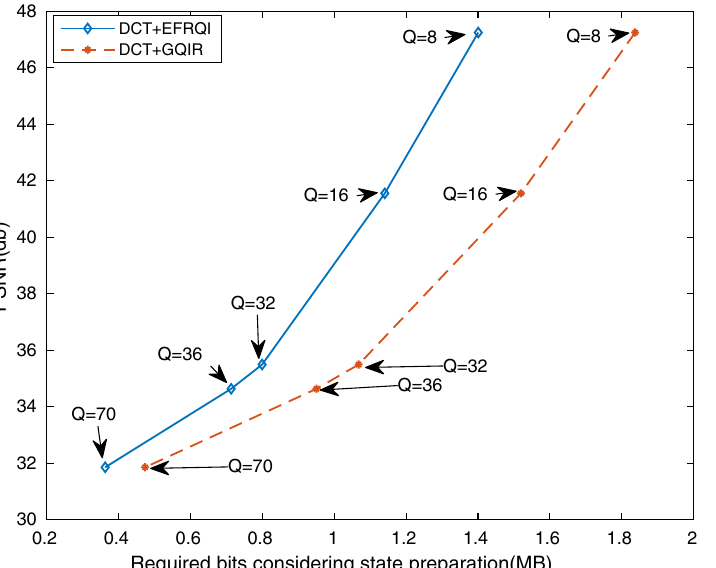
Figure 8. Required bits (MB) versus PSNR (db) for scenery